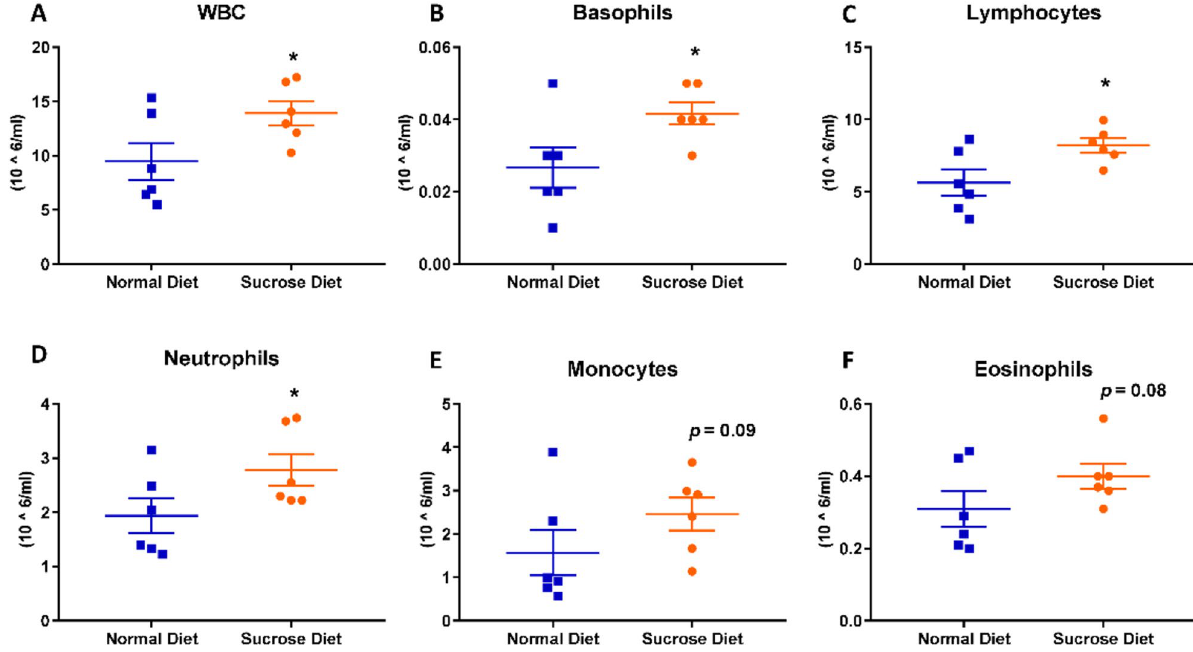
Figure 2. Blood profiling to detect peripheral inflammation following 12-week binge sucrose intake in rats. Blood profiling revealed elevated ( A ) white blood cells, ( B ) basophils, ( C ) lymphocytes and ( D ) neutrophils in rats in the sucrose-diet group as compared to the normal diet group. Increases in ( E ) blood monocytes and ( F ) eosinophils in the sucrose diet rats were not statistically significant. All values are presented as mean cell counts ± SEM (10 6 /ml) analysed with Student’s one-tailed t-test. *p < 0.05 compared with normal diet-fed controls. All values presented are from n = 6.